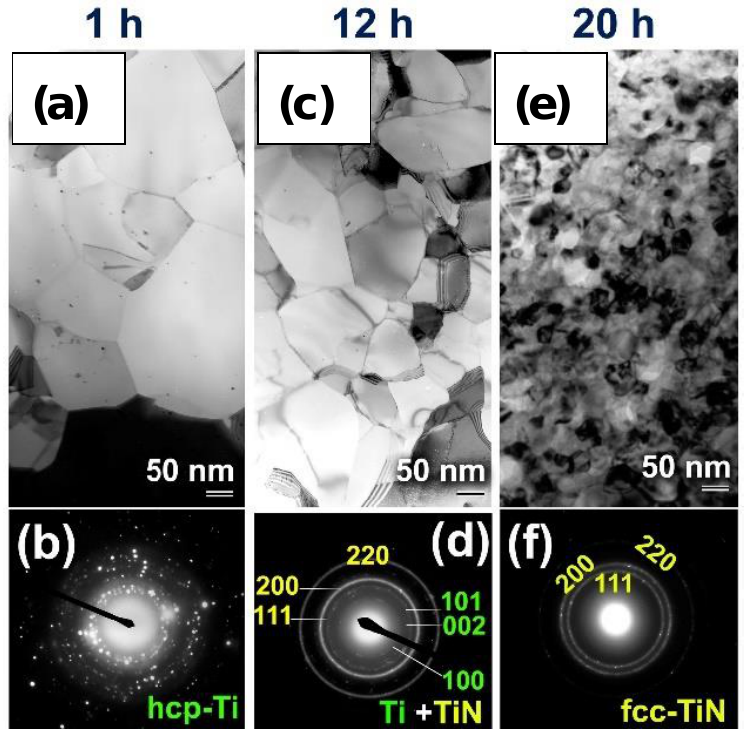
Figure 33. BFI and corresponding SADP of the planar view for as-consolidated and then ion-sliced powder samples obtained after ( a , b ) 1 h, ( c , d ) 12 h, and ( e , f ) 20 h of RBM.